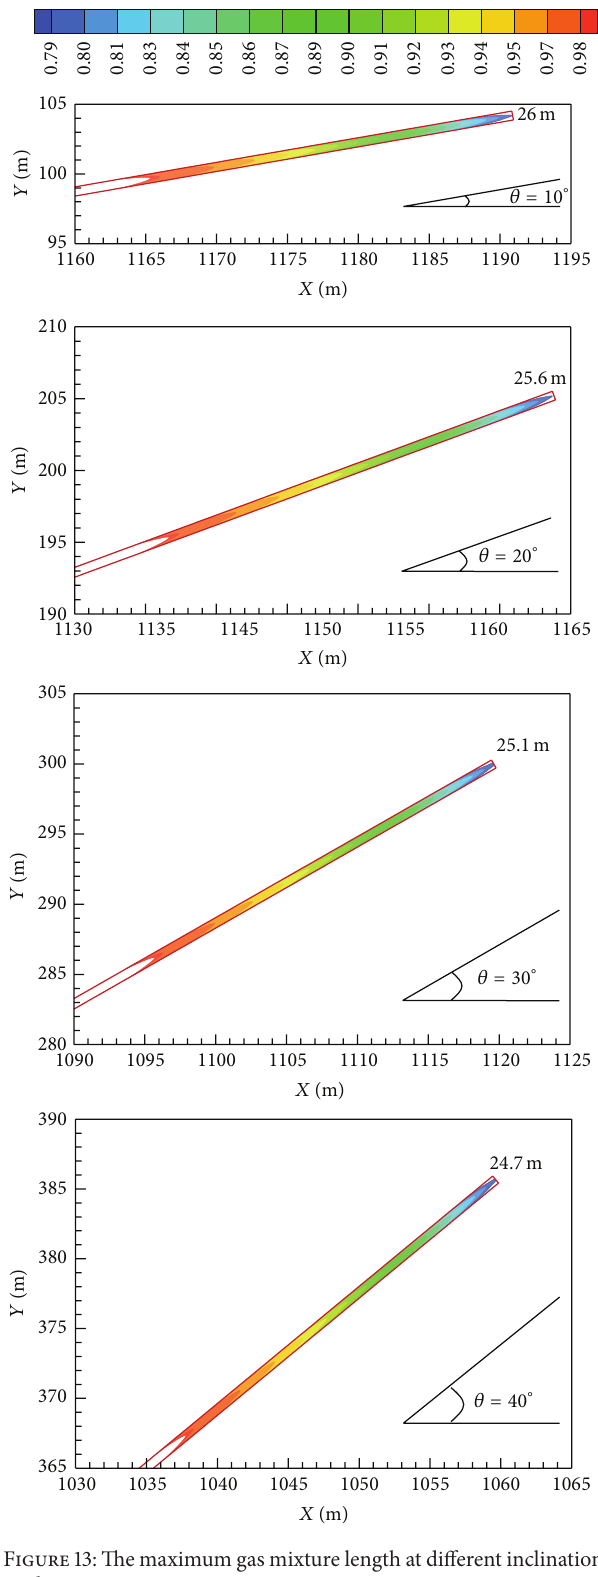
Figure 13: The maximum gas mixture length at different inclination angles.